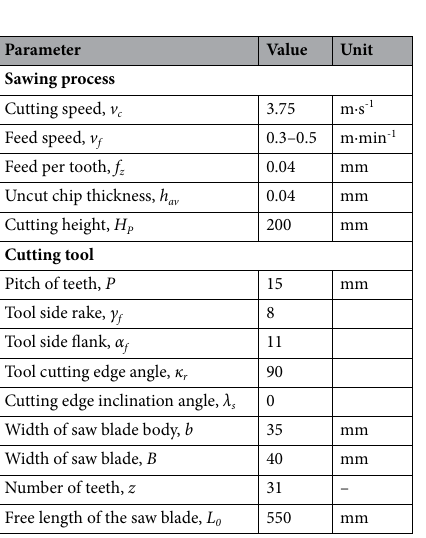
Cutting edge inclination angle, λ s 0 Width of saw blade body, b Free length of the saw blade, L Table 2. The parameters of the sawing process used for the analysis.